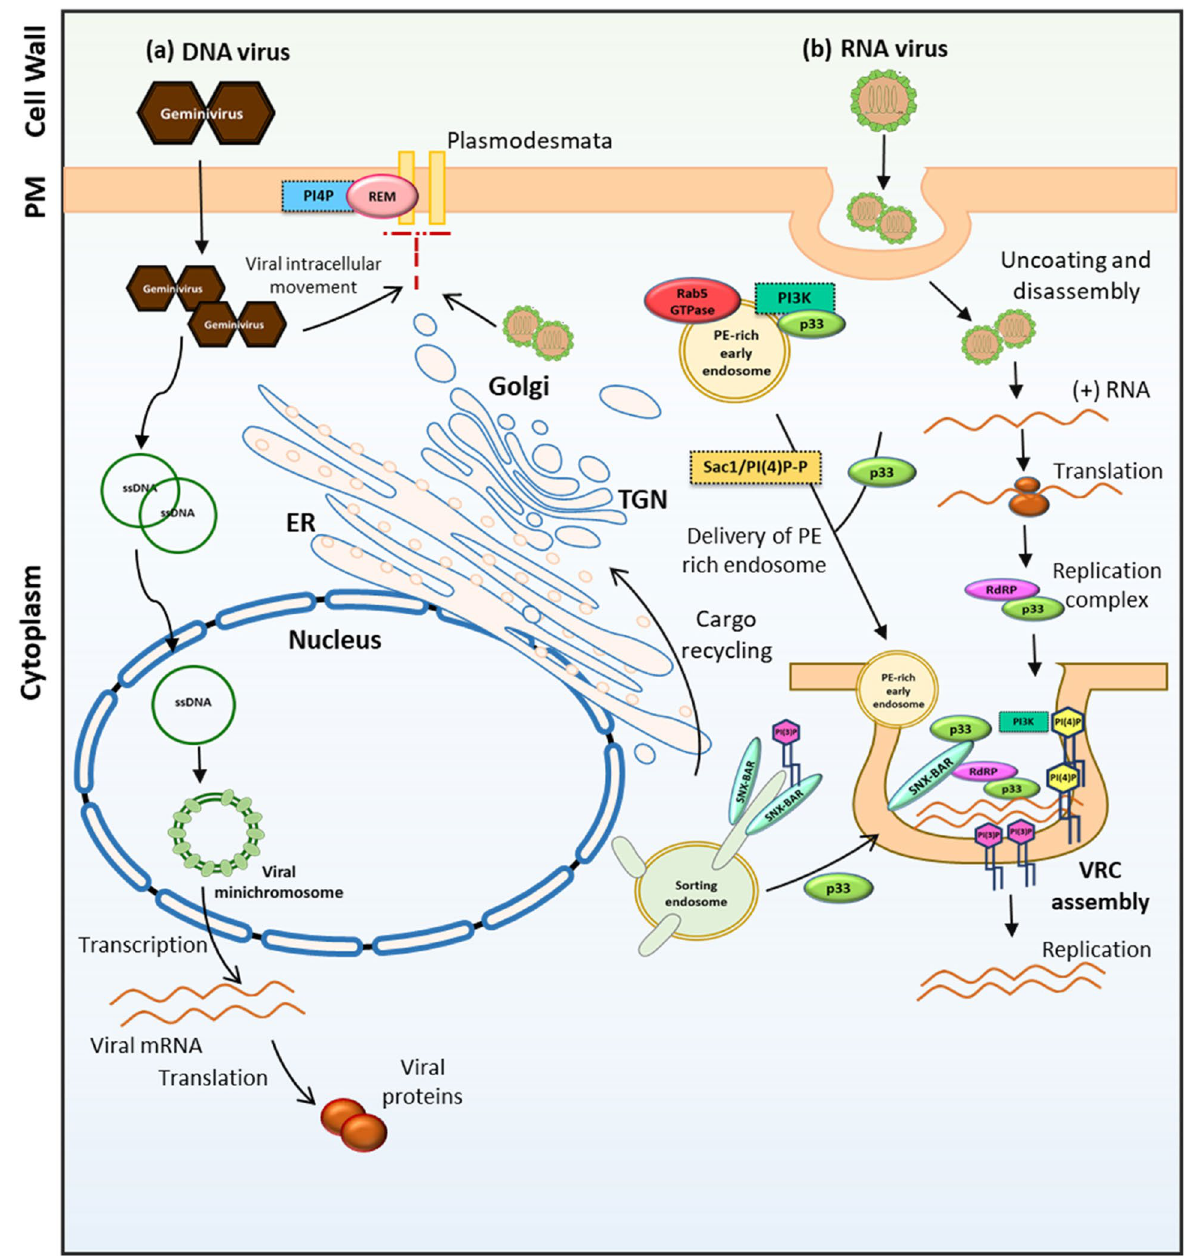
Fig. 4 Role of phosphoinositides in virus infection in plants. a REMORINs need to localize to the PM and they achieve PM anchoring by interacting with PI(4)P, where they affect plasmodesmata (PD) size exclusion limit and limit viral cell-to cell movement. b RNA viruses such TBSV form VRCs for replication. TBSV replication protein p33 helps the recruitment of PE rich Rab5 GTPase-positive endosomes in the TBSV VRC. TBSV p33 replication protein re-localizes the yeast SNX-BAR Vps5p into VRC as a permanent component of the viral replicase complex and the binding Vps5p to PI(3) P is required for this relocalization. PI(3)P, ssDNA, single-stranded DNA; PE, Phosphatidylethanolamine; RdRP, RNA-dependent RNA polymerase, p33 ,Tomato bushy stunt virus (TBSV) replication protein; VRC, viral replicase complexes; SNX-BAR, Sorting nexins-Bin/Amphiphysin/Rvs; PI(3)P phosphatidylinositol-3-phosphate; PI(4)P, phosphatidylinositol-4-phosphate; PI4K, phosphatidylinositol 4- kinase; Rab, Ras-related protein; REM, REMORIN; PM; plasma membrane; ER, endoplasmic reticulum; TGN, trans -golgi